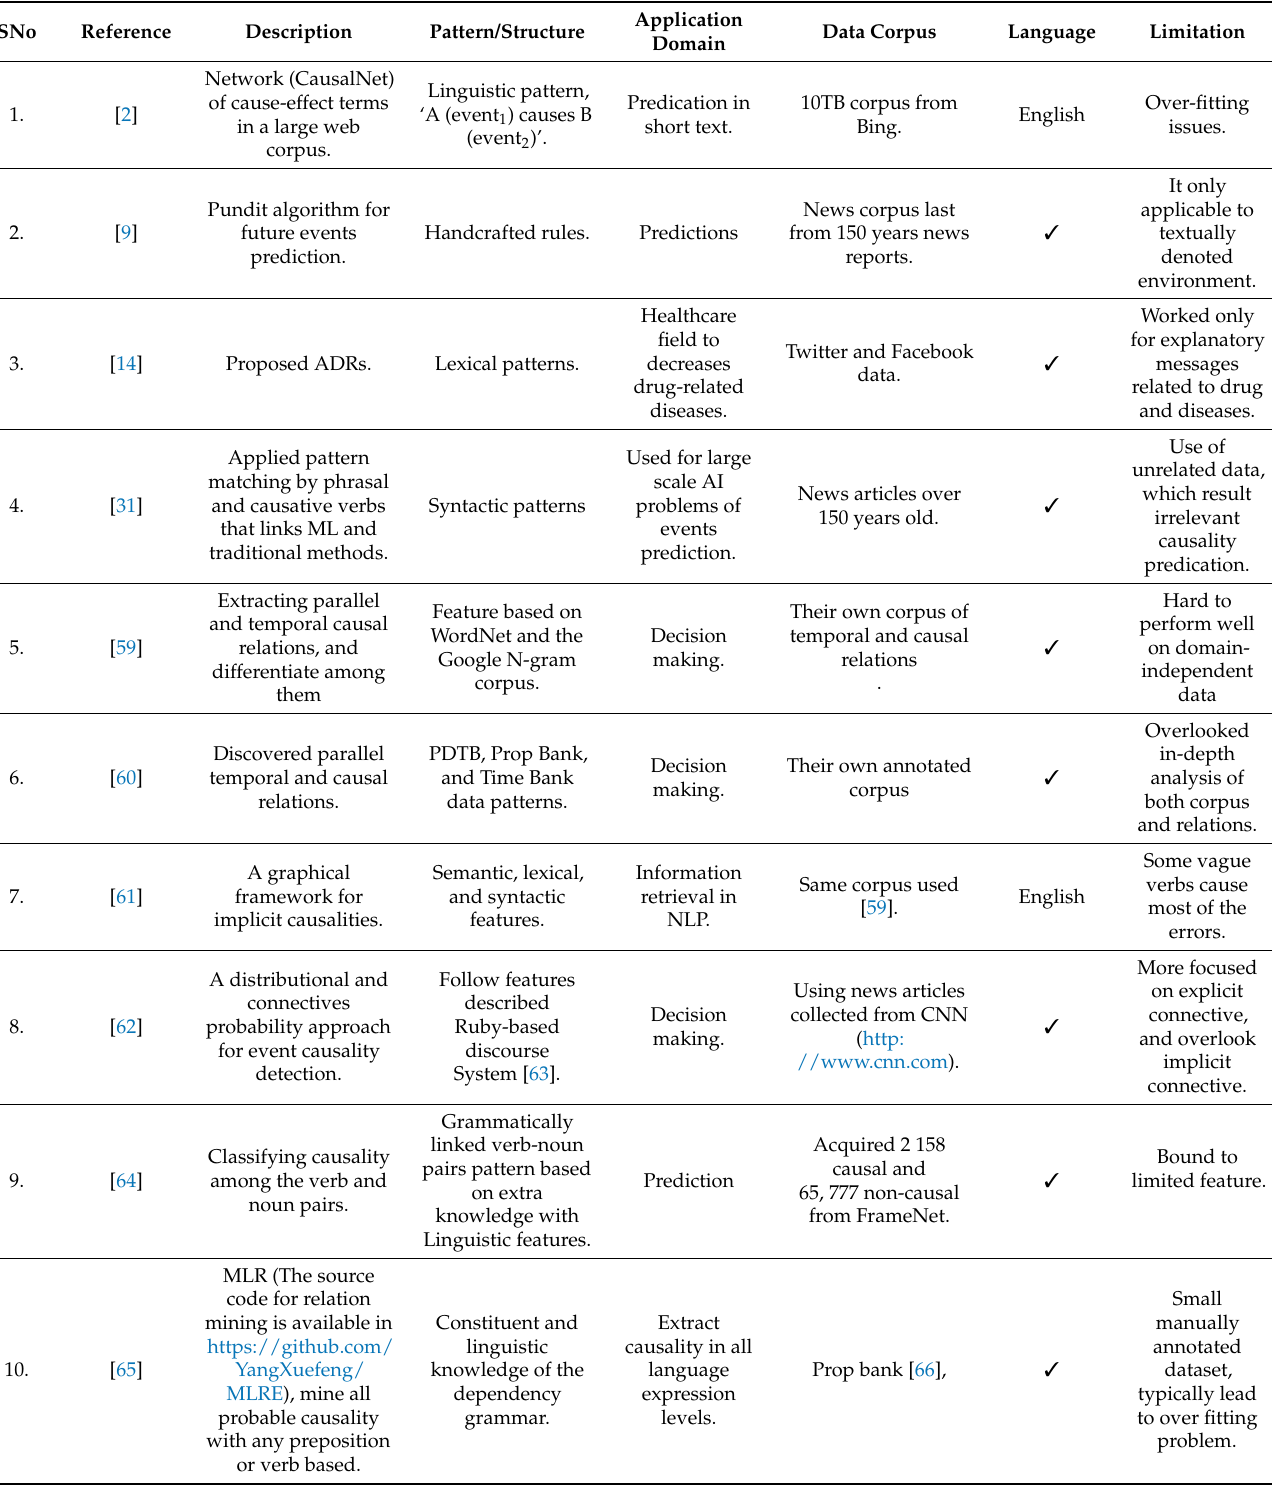
Table 2. Reviews ML approaches for implicit and ambiguous